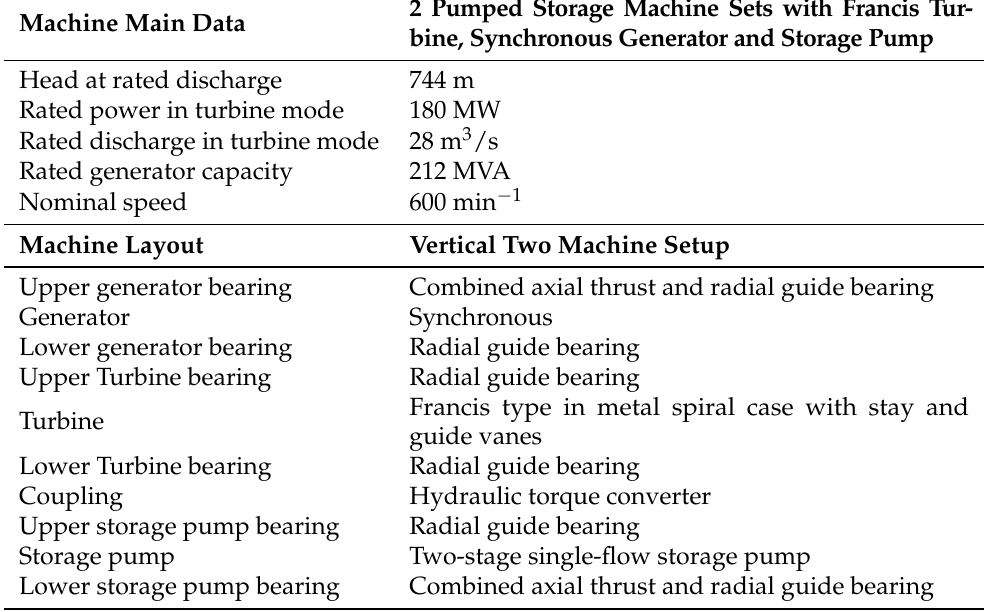
Table 1. Machine main